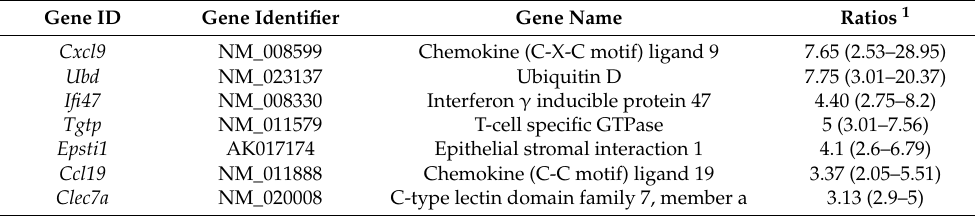
Figure 2. Identification of disease-relevant genes in lacrimal glands of mouse models of Sjögren syndrome. Microarray data sets described elsewhere were analyzed to identify disease-relevant genes upregulated in the context of lacrimal gland inflammation in four different scenarios based on sex or exposure to testosterone. The NOD mouse lacrimal gland data sets include genes upregulated at least 2-fold in male compared to female mice (set 1) or testosterone-treated female compared to placebo-treated female mice (set 2) as testosterone exposure is associated with dacryoadenitis in NOD mice. The MRL/lpr lacrimal gland data sets include genes upregulated at least 2-fold in female compared to male mice (set 3) or placebo-treated female compared to testosterone-treated female mice (set 4) as testosterone is relatively protective and associated with decreased dacryoadenitis in MRL/lpr mice. Each of the 4 data sets depicted in the figure represents the gene sets that were upregulated at least 2-fold for the indicated two-group comparison in analyses of two different microarray platforms (Affymetrix and CodeLink platforms–as noted in Table 1) for the indicated comparison. The intersection of all data sets resulted in 7 genes (see Table 1). Table 1. Genes upregulated in the context of lacrimal gland disease in NOD and MRL/lpr